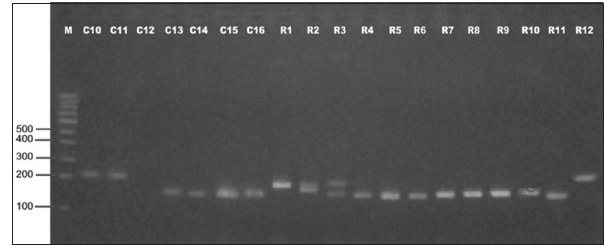
Figure-2: Polymerase chain reaction amplicons of spa gene (X-region) of Staphylococcus aureus isolates from Holstein–Friesian crossbred cattle (C10-C16) and Rathi cattle (R1-R12) with subclinical